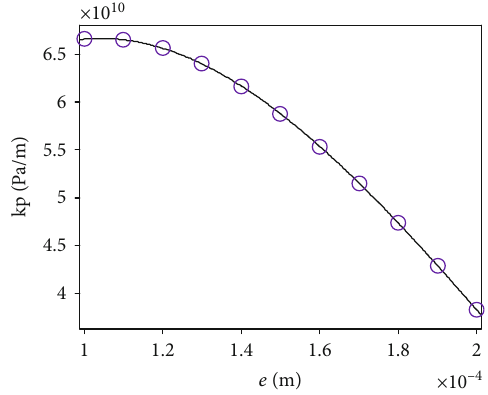
Figure 7: Material removal at the top of the boss.